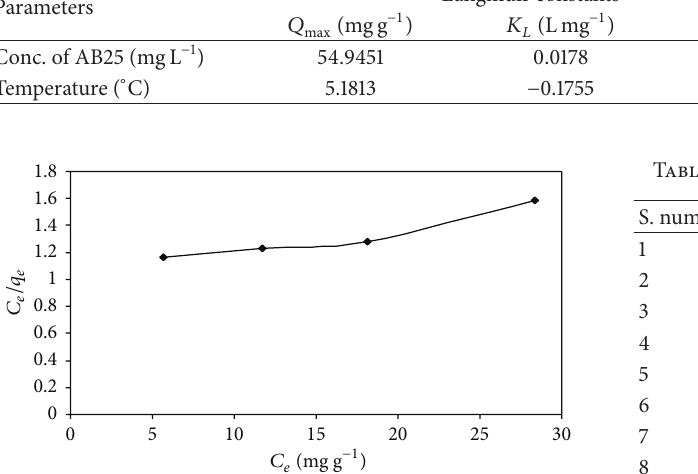
Figure 12: Langmuir isotherm of AB25 on IJSP at 35 ± 1 ∘ C. Condi- tions as in Figure 8.